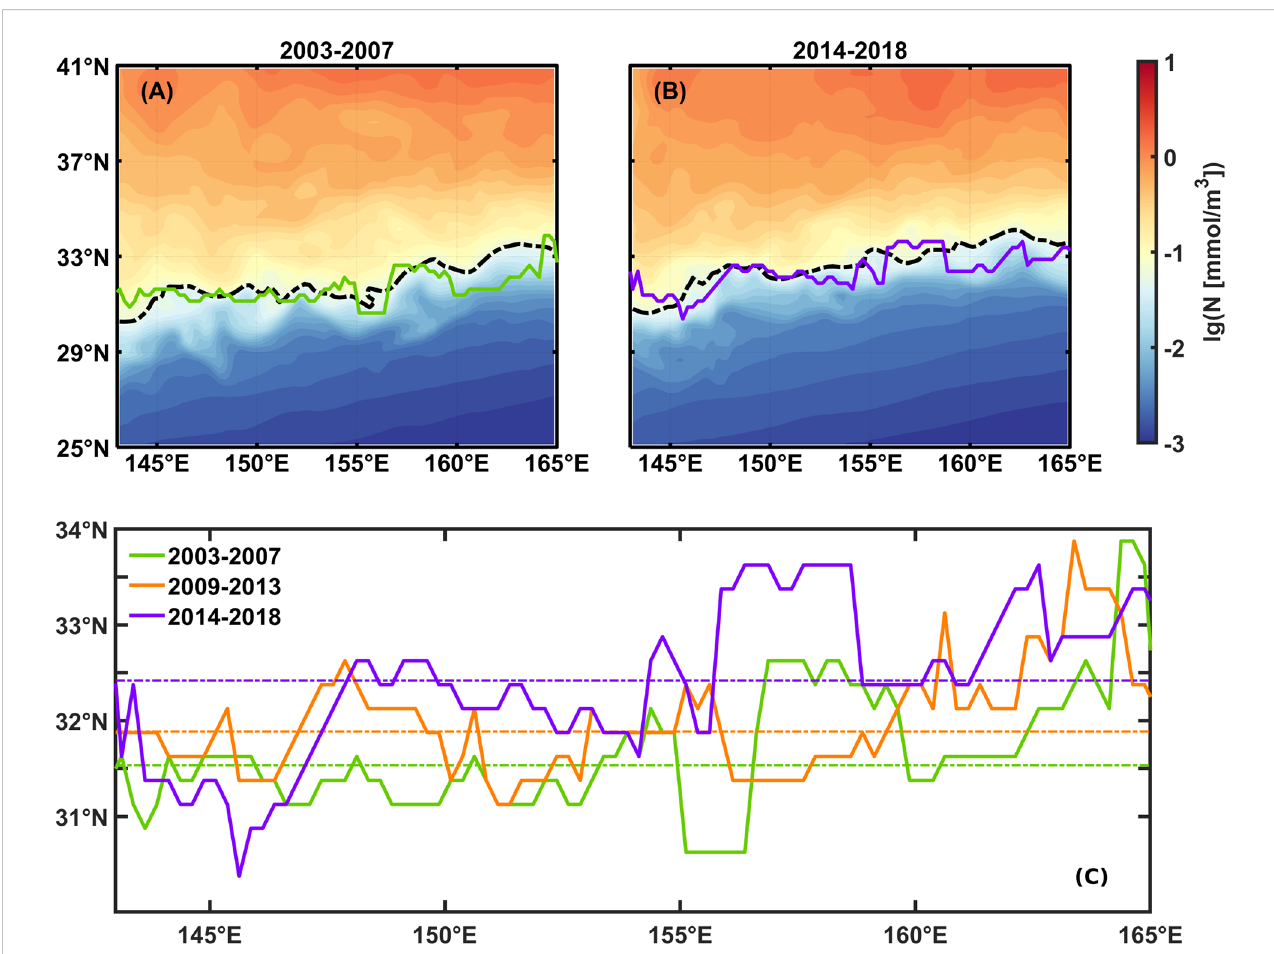
FIGURE 12 Emergence boundaries of fall blooms and averaged surface 10 -1.2 mmol/m 3 N (broken black line) in fall (October-December) averaged during (A) 2003 to 2007, (B) 2014 to 2018, the emergence latitudes of the fall bloom (solid line), and averaged surface N in fall (shading), and (C) the comparison between three boundaries, broken lines indicate average latitude of each boundary.